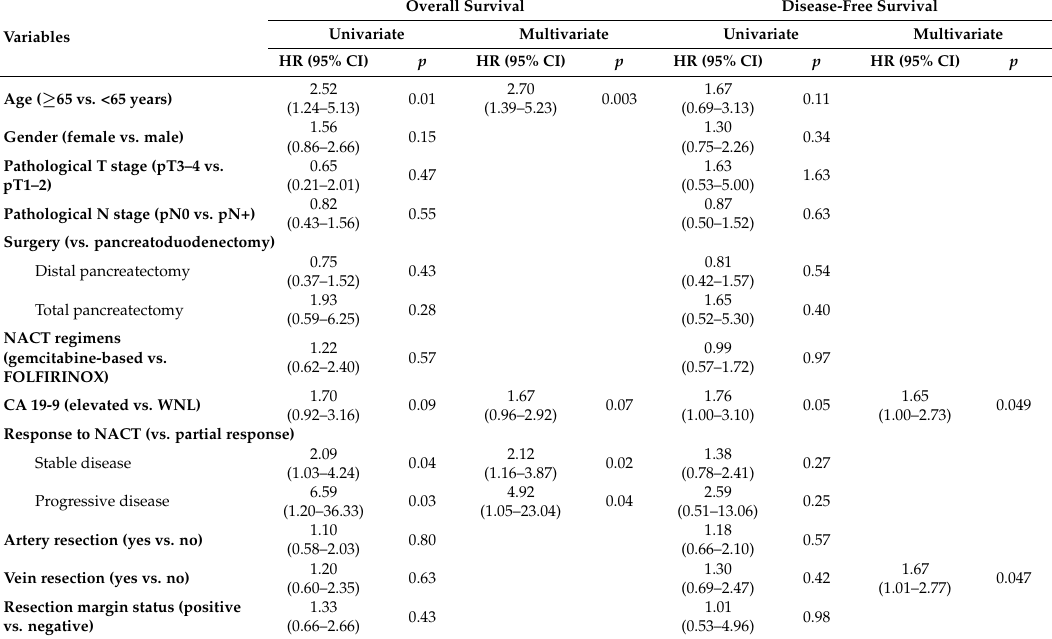
Table 4. Univariate and multivariate analyses of overall survival and disease-free survival in patients with conversion surgery after neoadjuvant chemotherapy.